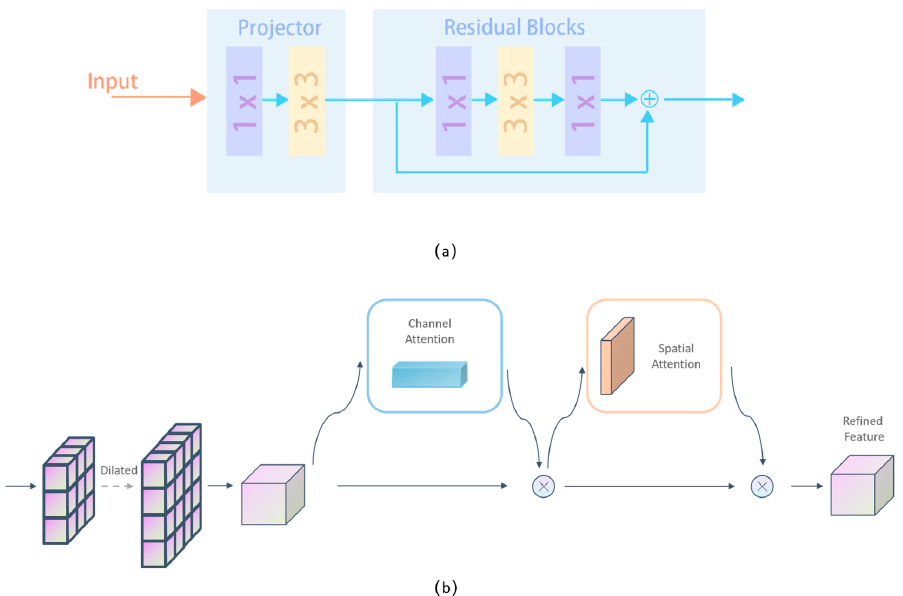
Figure 6. The structure of encoder. ( a ) 1 × 1 and 3 × 3 means the convolution layers, in StrMCsDet, with eight successive residual blocks with dilated and attention module. ( b ) The 3 × 3 convolution layer includes dilated block, then the channel and spatial attention module to enhance the feature map.